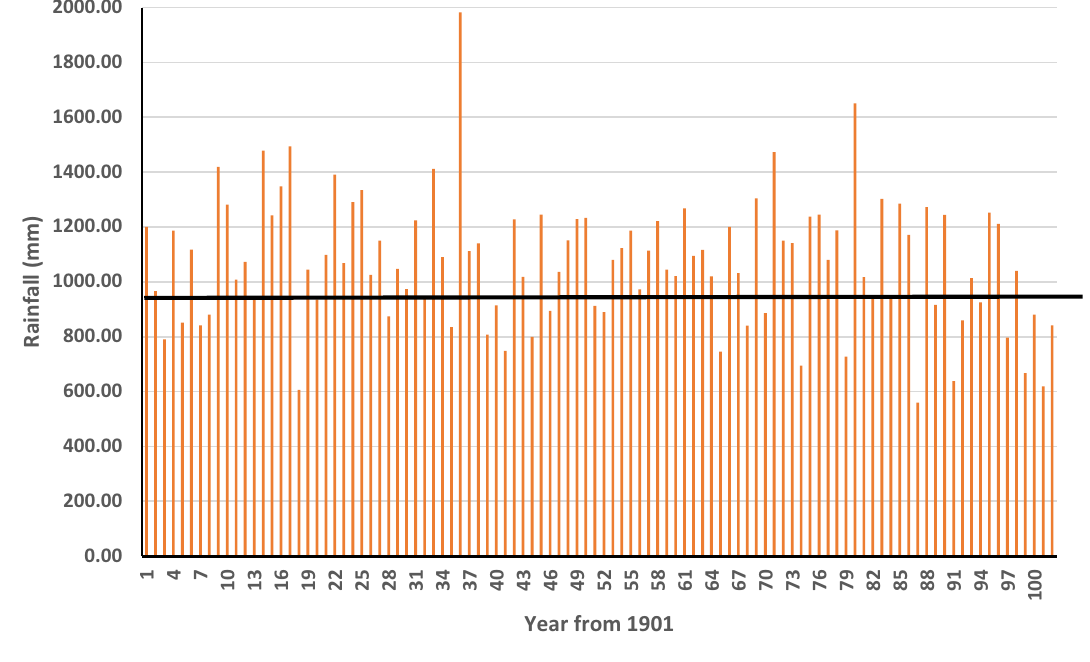
Fig. 3 Average annual precipitation of Uttarakhand from 1901 to 2002 Fig. 4 Seasonal variation of